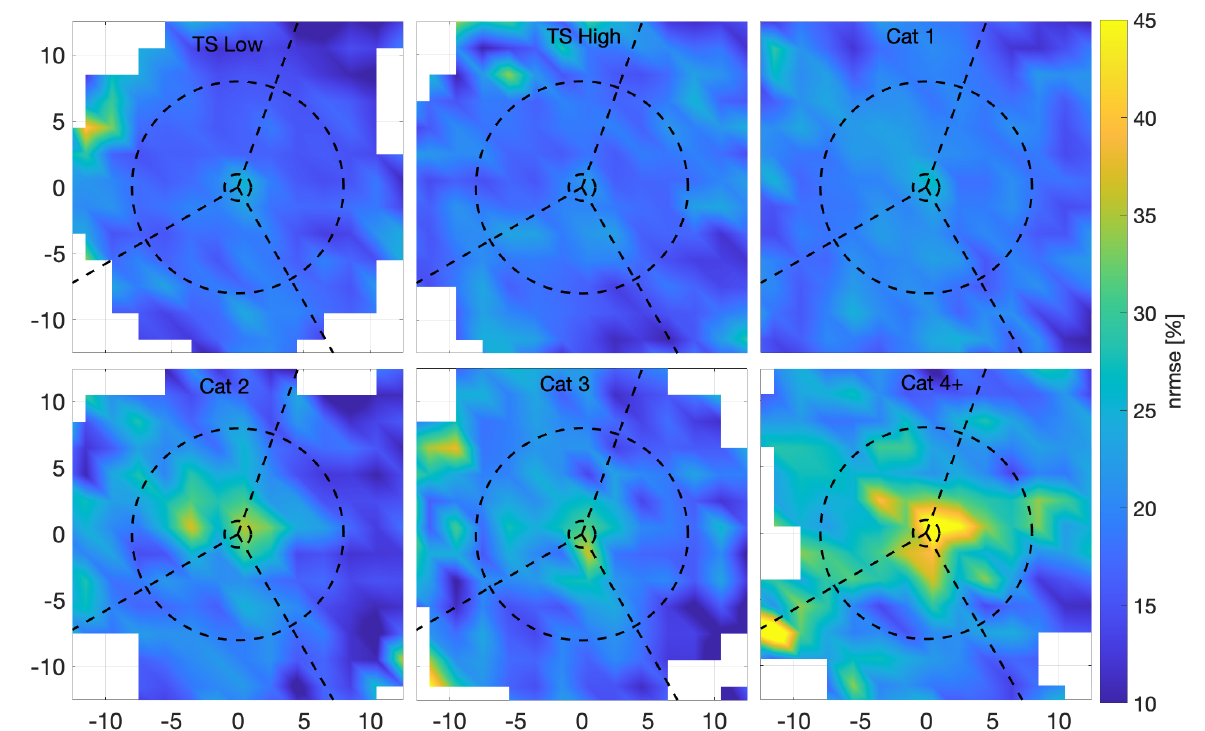
Figure 14. Each subplot as in Figure 12b for each category of the S-S intensity scale (note the difference in color